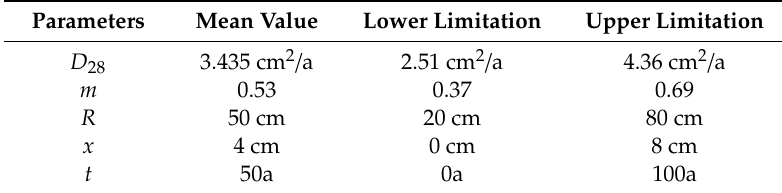
Table 2. Parameter value range of sensitivity analysis.